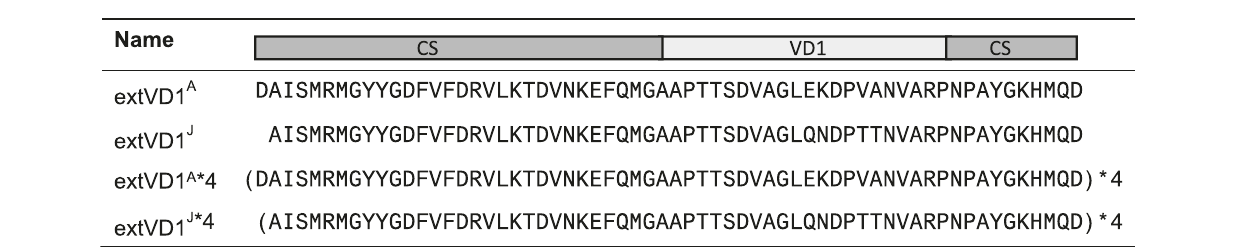
Table 1. Sequences of VD1 based vaccine constructs.